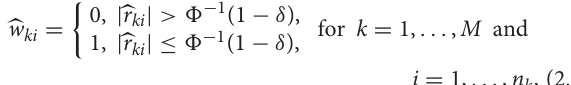
TABLE 2 | Results for high-dimensional data with clean data. M =